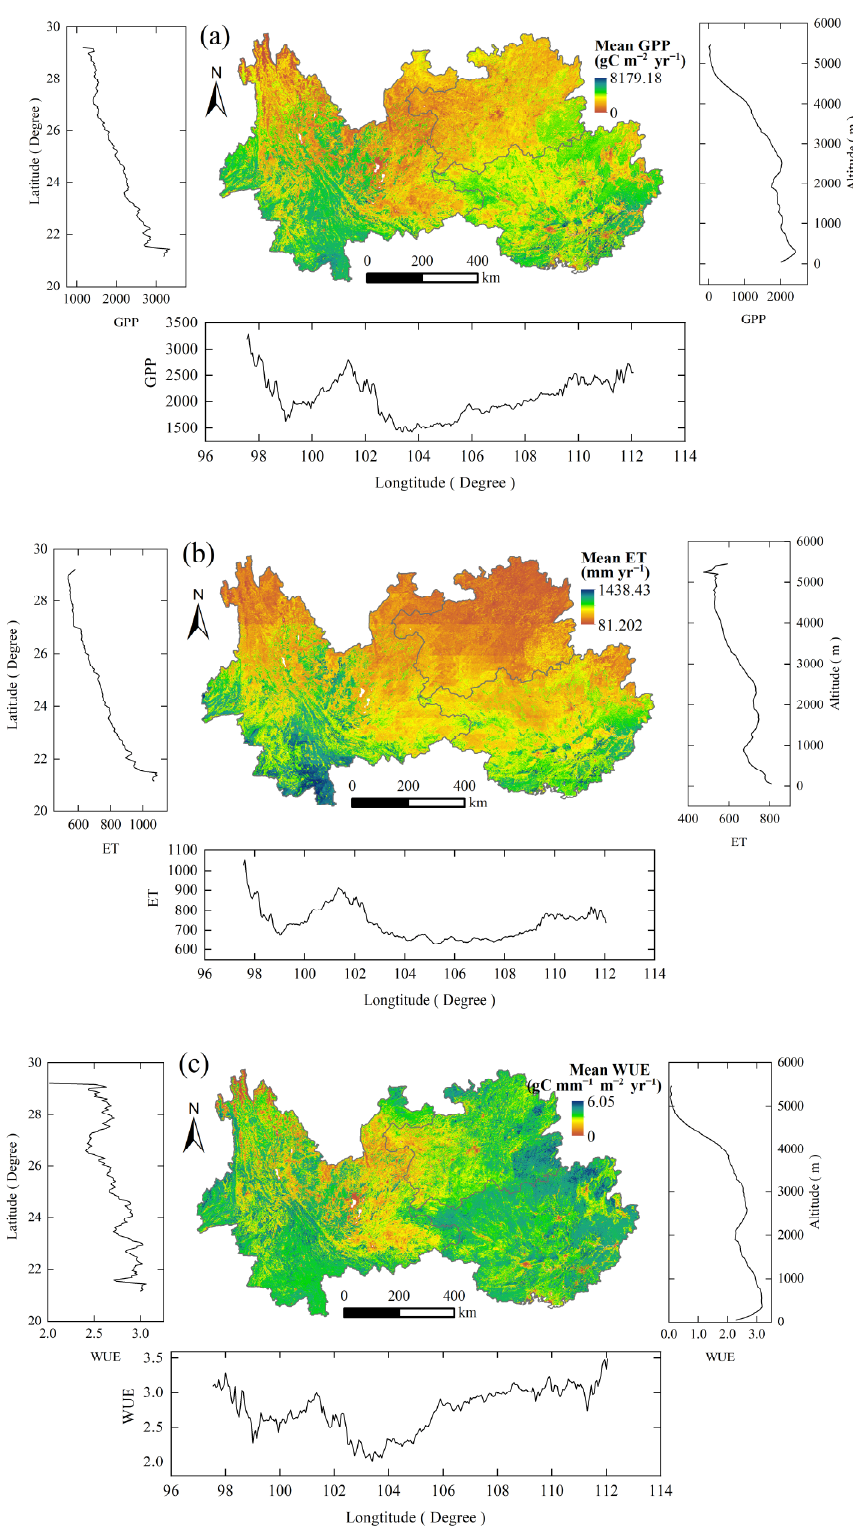
Figure 2. Spatial patterns of multi-year mean values of ( a ) GPP, ( b ) ET, and ( c ) ecosystem WUE. The statistics of longitude, latitude, and elevation are presented in the bottom panel, left panel, and right panel, respectively.